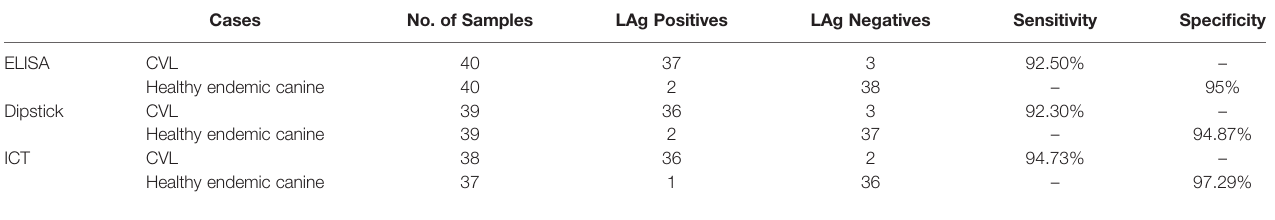
TABLE 1 | Performance of LAg-based ELISA, dipstick test, and ICT with sera from Universidade Federal do Piaui (UFPI), Brazil.